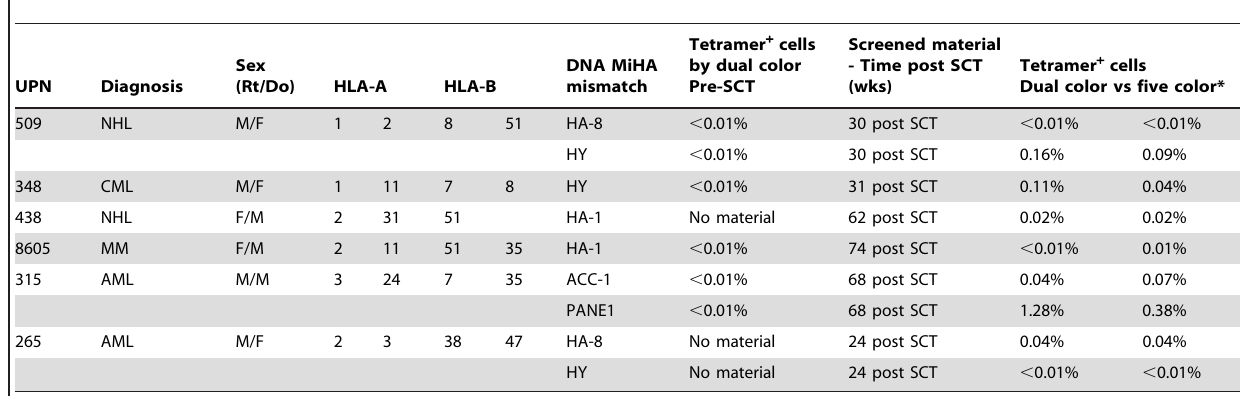
Table 2. Characteristics of SCT recipients containing circulating MiHA-specific CD8 + T